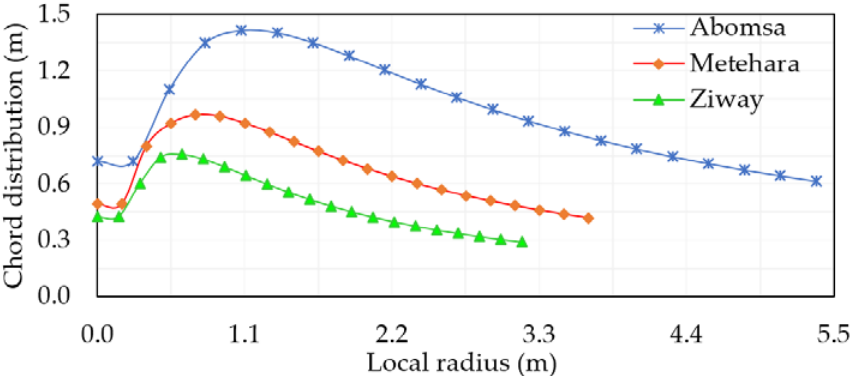
Figure 11. Comparison of chord distribution of three specific local sites.